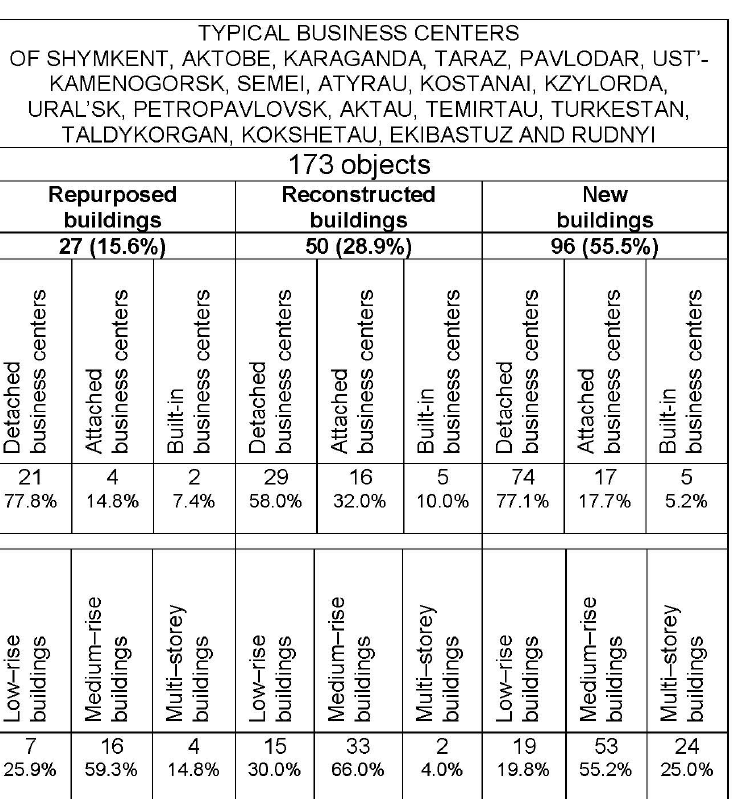
Figure 25. The differentiation of the characteristic business centers of Astana and Almaty.